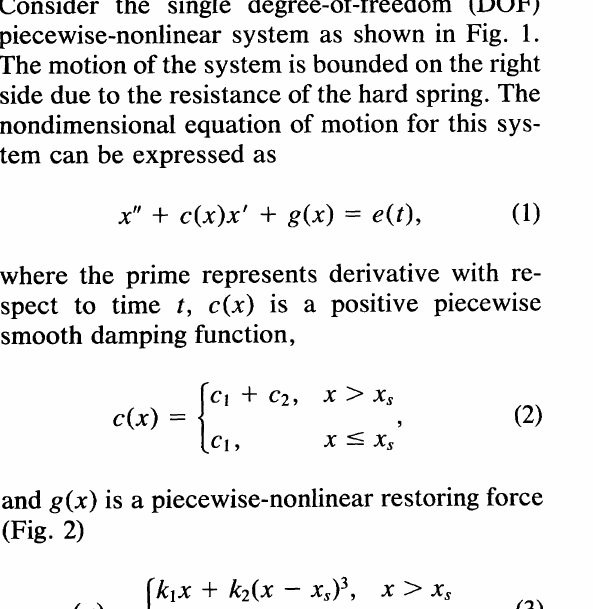
FIGURE 2 Piecewise-nonlinear